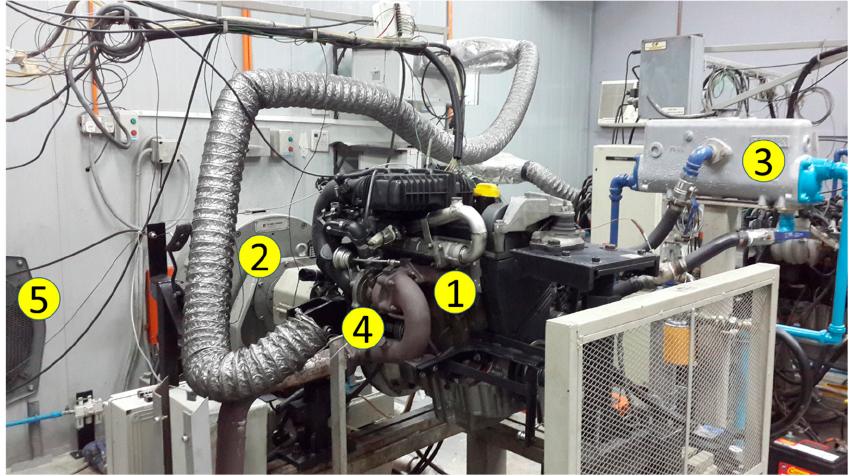
Figure 1. Schematic of the experimental apparatus: ( 1 ) test engine; ( 2 ) Eddy current dynamometer; ( 3 ) engine coolant heat exchanger; ( 4 ) turbocharger; ( 5 ) ventilation fan. Table 3. Test engine parameters.